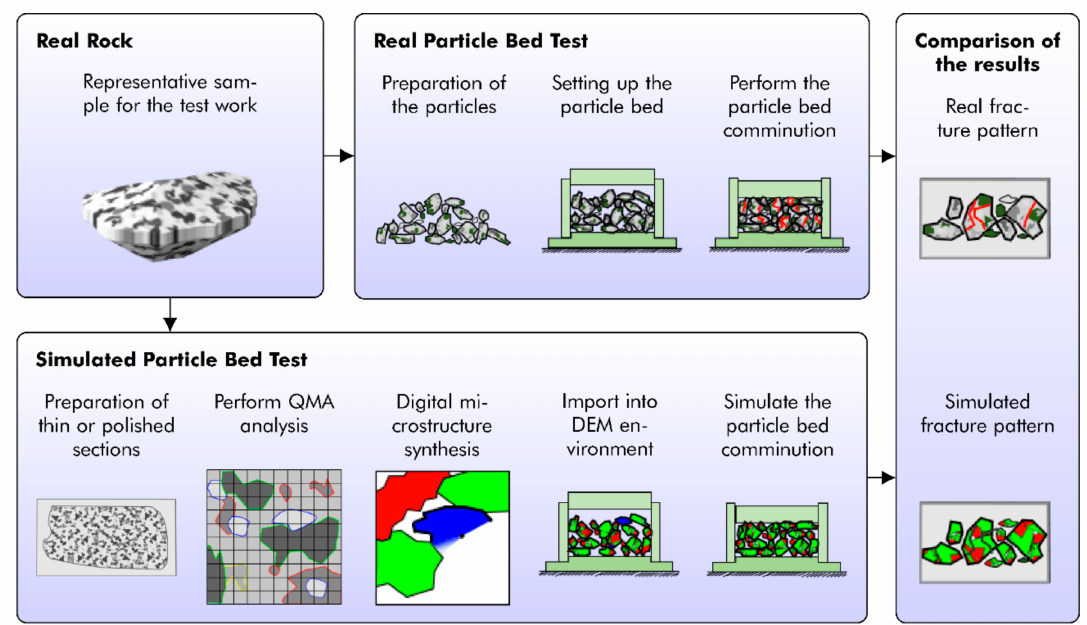
Figure 1. Schema for parallel real particle bed comminution and simulation in a piston die